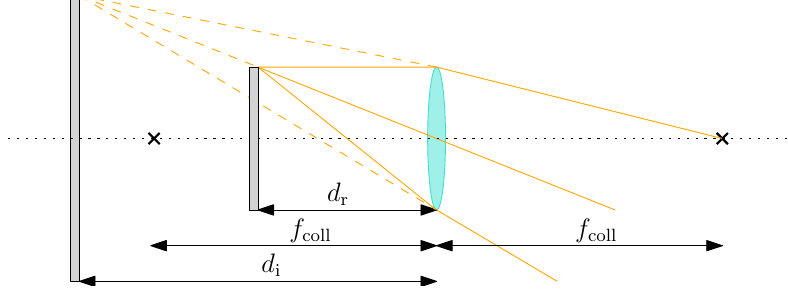
Figure 1. Geometrical configuration for the lens equation of the collimator in